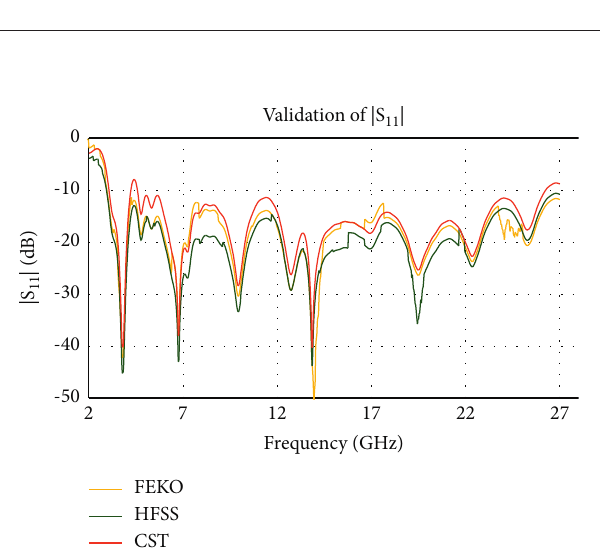
Figure 9: Validation of return loss curve of the proposed Vivaldi